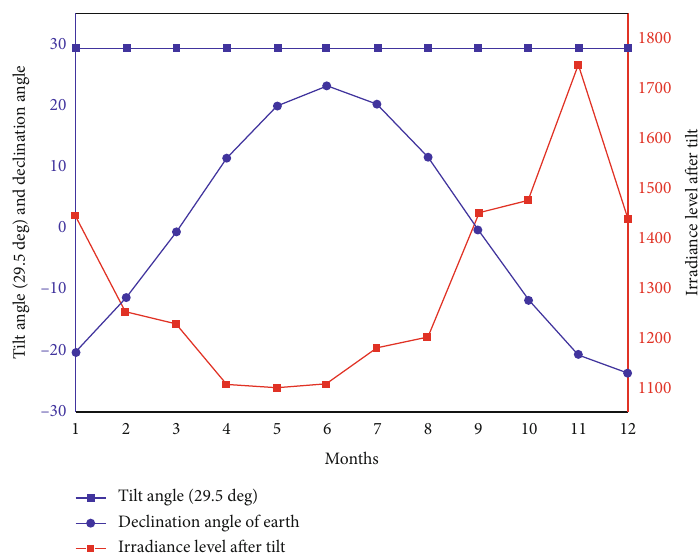
Figure 4: Speci fi c monthly irradiance on optimal fi xed tilt angle (29.5 deg) and declination angle versus